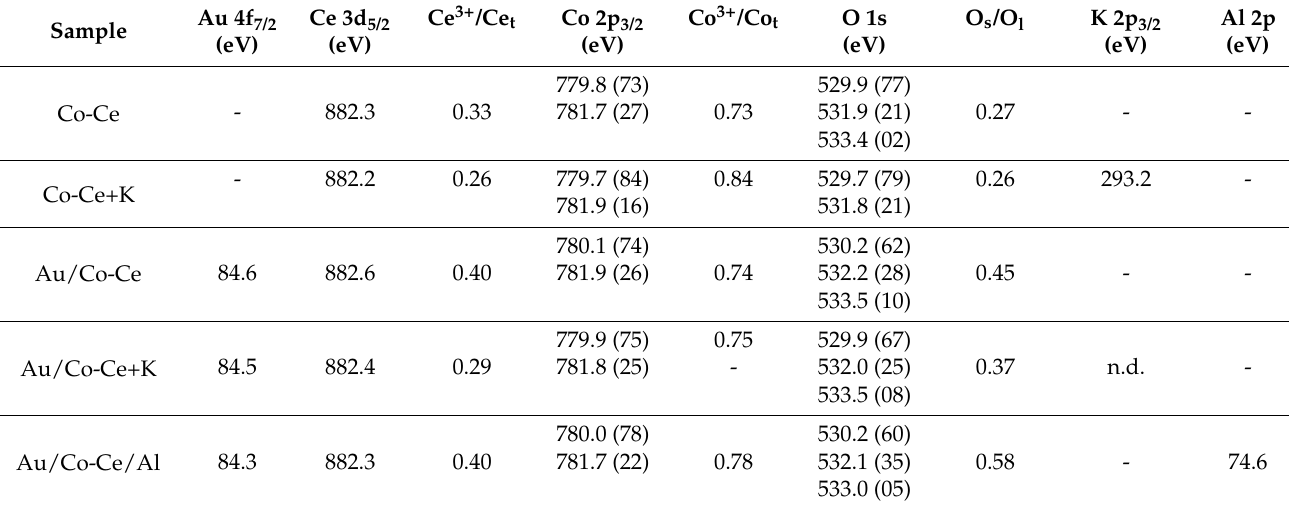
Table 3. XPS binding energies and atomic